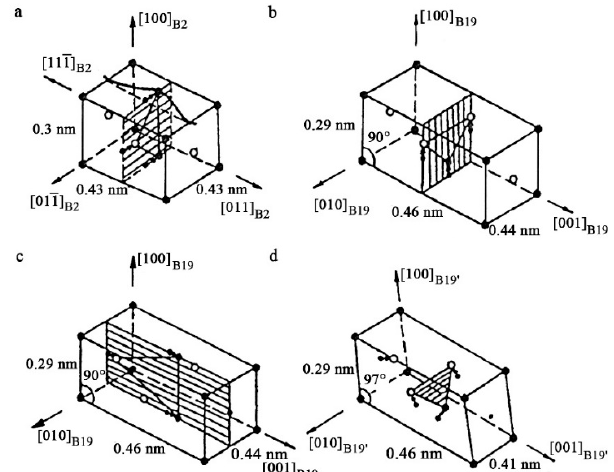
Figure 3. Unit lattice cells of the ( a ) B2-, ( b , c ) B19- and ( d ) B19 ′ phases in titanium nickelide alloys, their dimension-orientational ratios and schemes of rearrangements determined by shuffling (of type {011} < 100 > and {011} < 011 > ) atomic displacements (shear basal planes {011} B2 shaded) [17] (Copyright, 1989, Physics of Metals and Metallography).